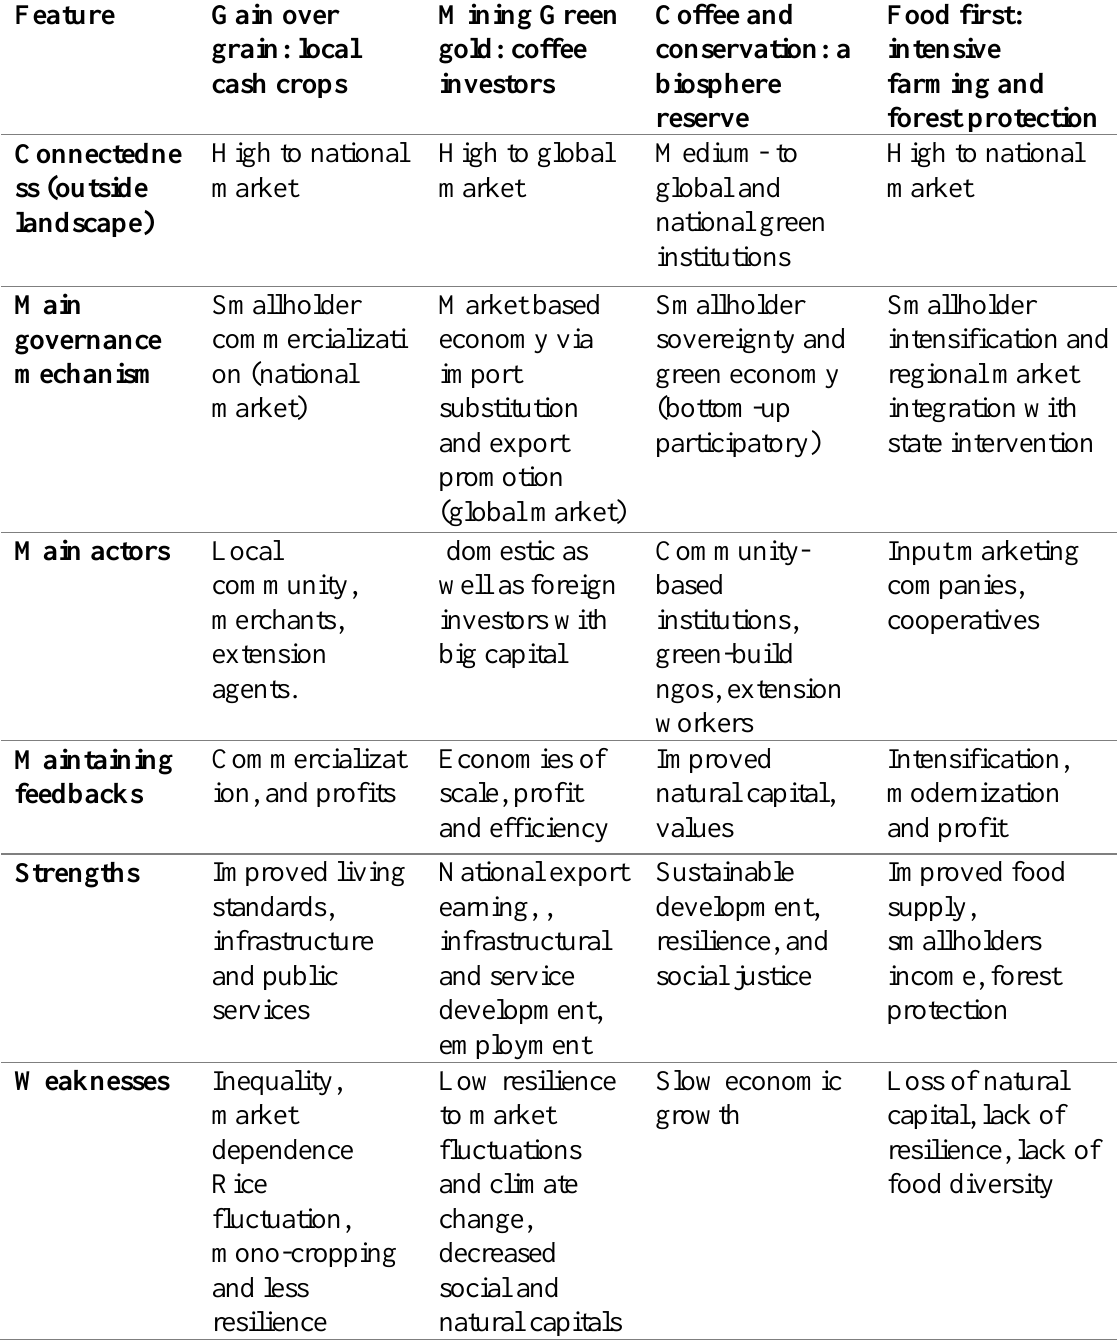
Table A1.2. Key features of the four scenarios .